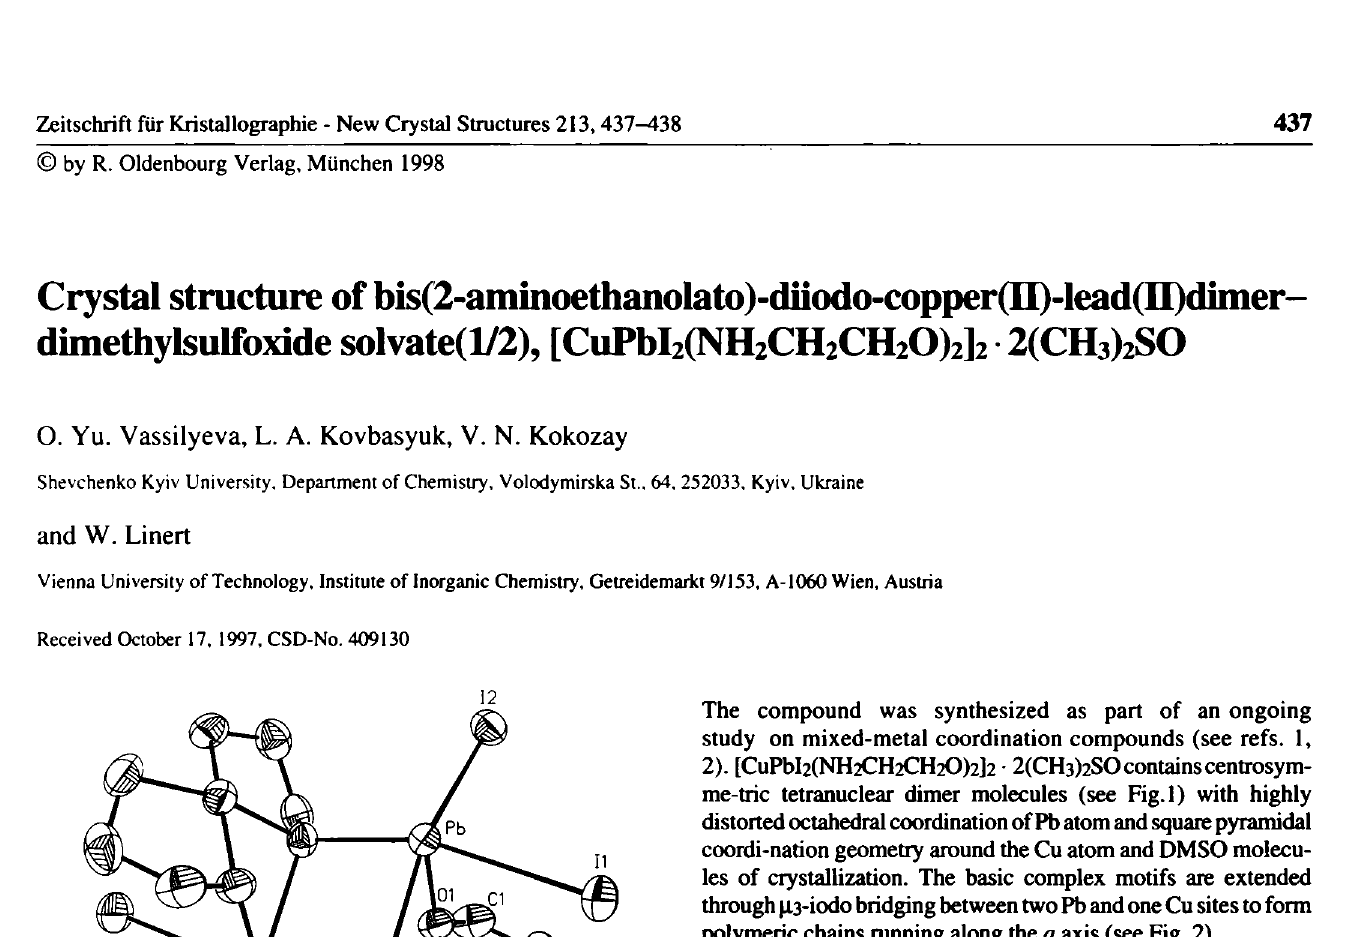
Table 1. Parameters used for the X-ray data collection Crystal: